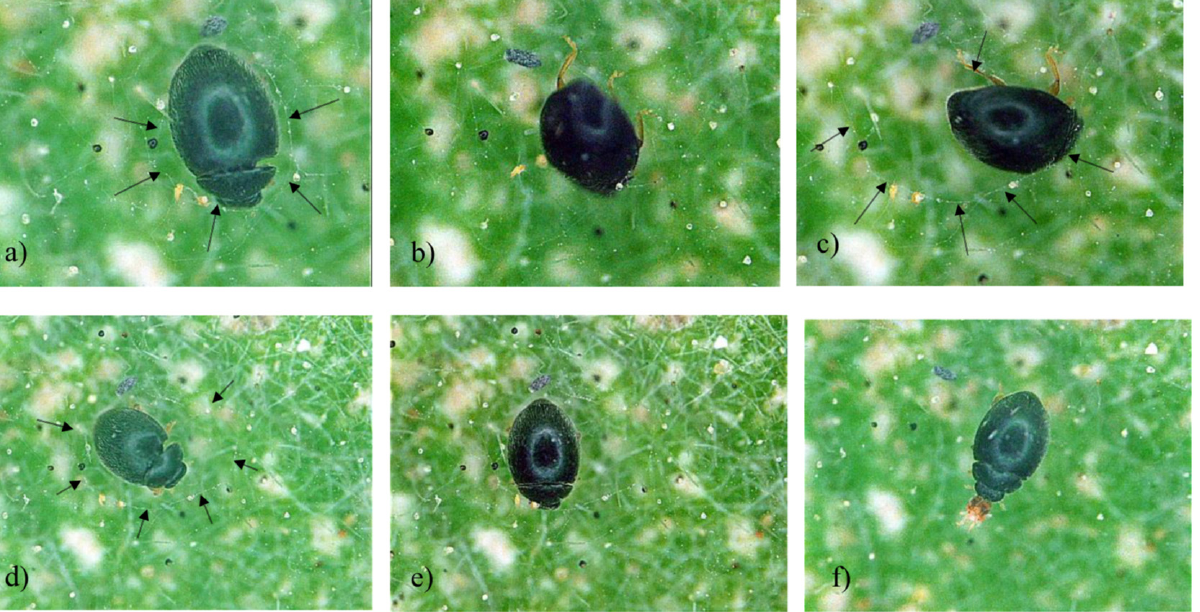
Figure 2. The specialist mite predator Stethorus gilvifrons coping with the web of the two ‐ spotted spider mite, Tetranychus urticae : ( a ) predator made entry hole by cutting; ( b ) predator forcing entry; ( c , d ) predator using legs and body movement to widen hole; ( e ) predator widened the hole for easy entry; ( f ) predator feeding on female mite. Arrows represent the size of the entry hole.